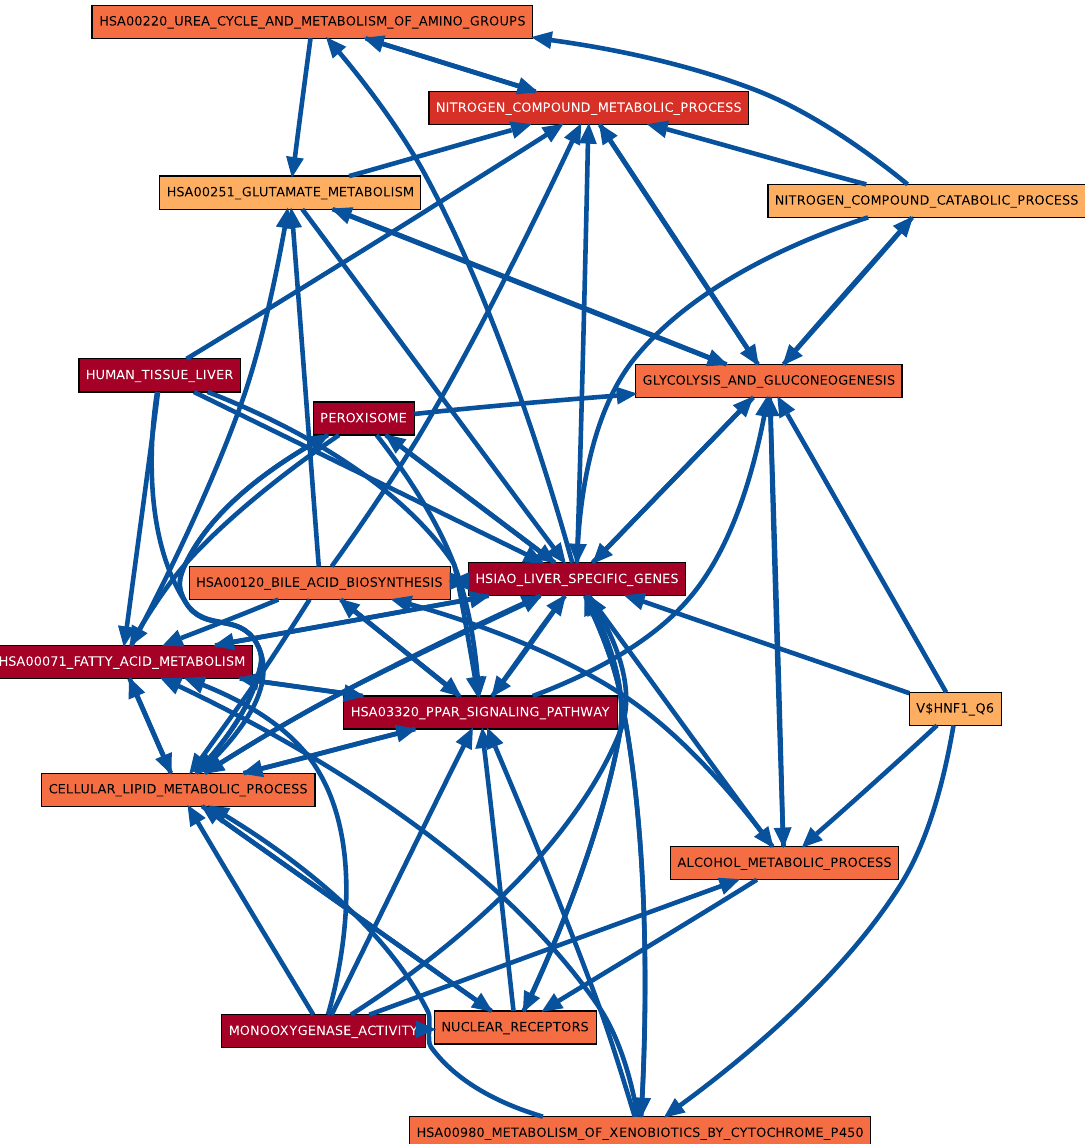
Figure 4. CS vs. HM CBPLN on day 8.